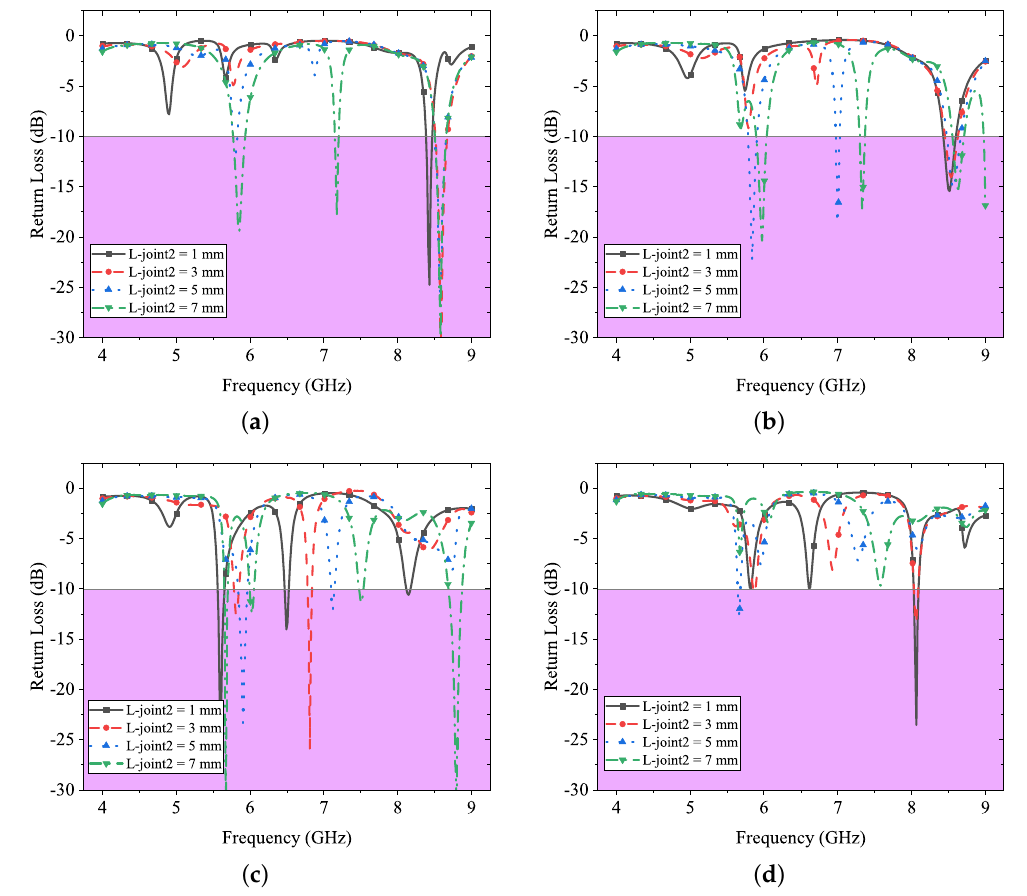
Figure 6. Effect of the joint2 length ( L joint 2 ) on return loss performance. ( a ) Parametric sweep when X joint 2 = 0 mm; ( b ) Parametric sweep when X joint 2 = 1 mm; ( c ) Parametric sweep when X joint 2 = 2 mm; and ( d ) Parametric sweep when X joint 2 = 3